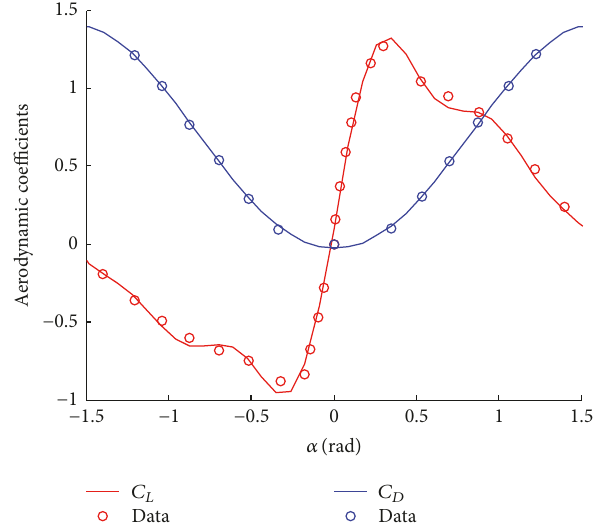
Figure 3: The curves of the aerodynamic lift coefficient 𝐶 𝐿 and the aerodynamic drag coefficient 𝐶 𝐷 against the angles of attack 𝛼